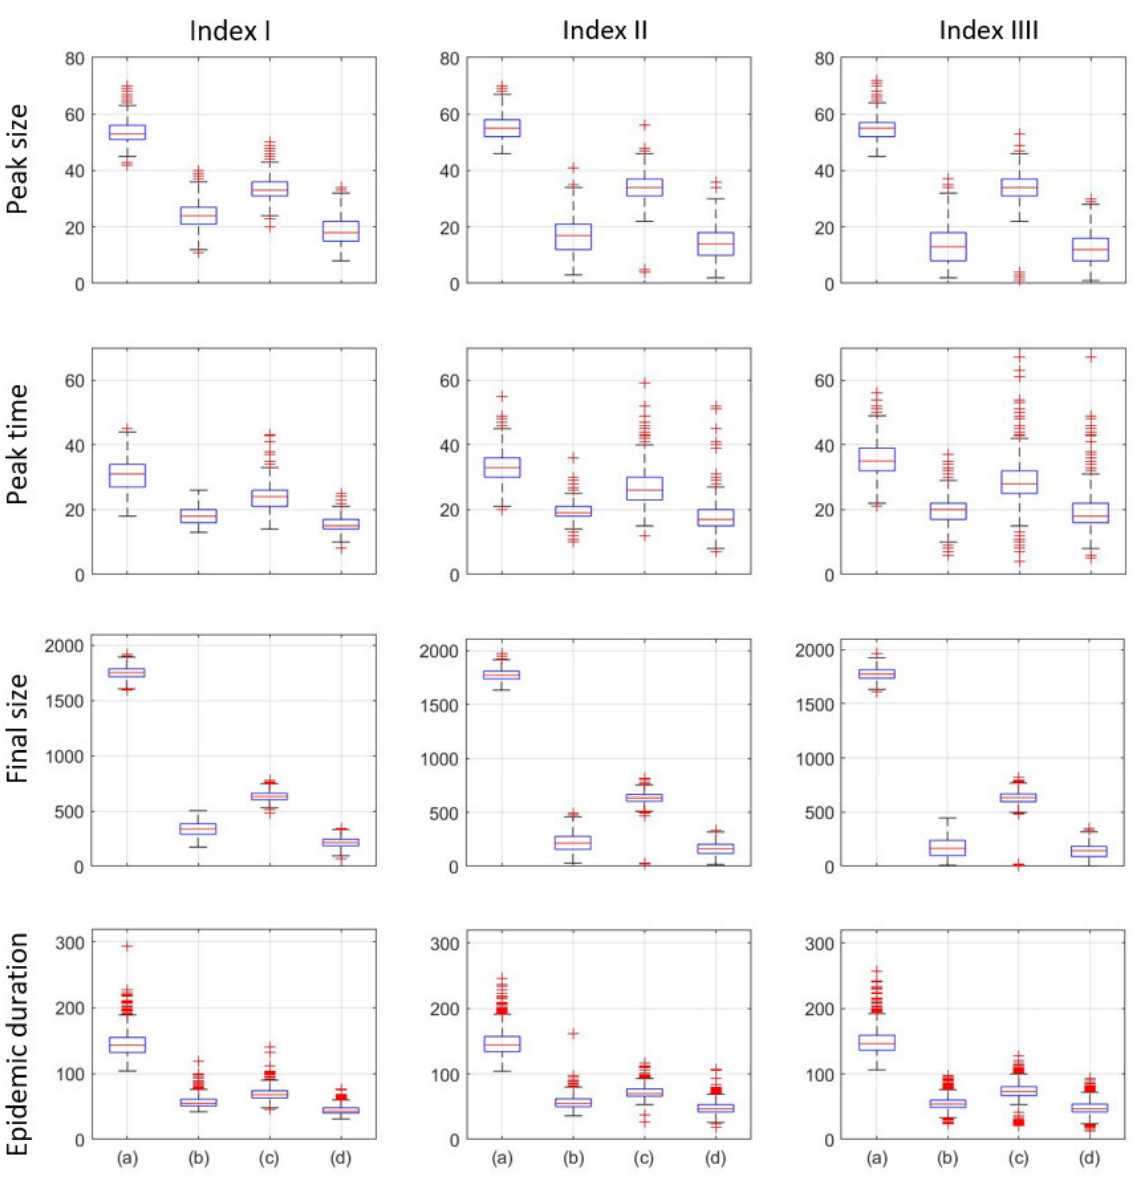
Figure 6. Epidemic outputs: peak size, peak time, final size, epidemic duration are compared under three interventions. For each intervention, 1000 runs are simulated and the average are displayed under three index cases. Clearly, AQ + Isolation is the most effective intervention as shown in (d) of each